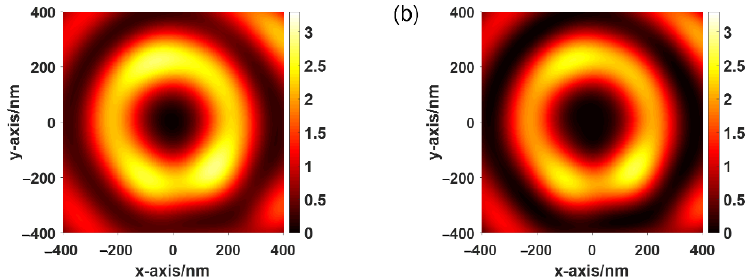
Figure 7. Distribution of ( a ) total electric field strength, and ( b ) longitudinal electric field strength when the incident light is RCP.